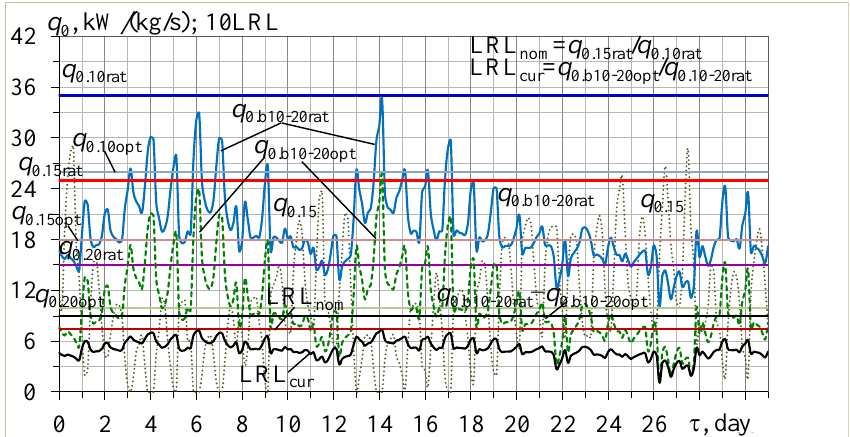
Figure 8. Actual refrigeration capacities q 0.15 needed for preconditioning outdoor air to 15 °C, booster refrigeration capacity q 0.b10-20opt and q 0.b10-20rat based on q 0.10opt and q 0.10rat , the difference q 0.b10-20rat − q 0.b10-20opt = q 0.10rat − q 0.10opt , current LRL cur and nominal LRL nom : q 0.b10-20rat = q 0.10rat − q 0.10-20 , q 0.b10-20opt = q 0.10opt −